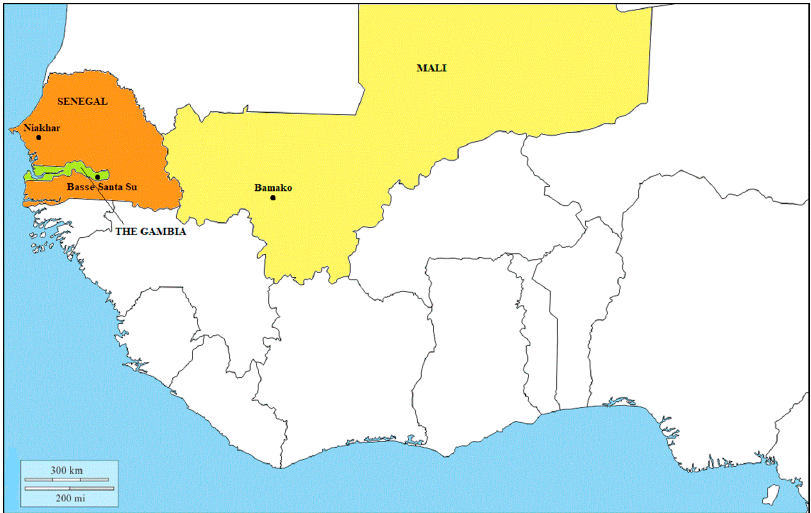
Figure 1. West African region, study sites in Mali (yellow), Senegal (orange) and The Gambia (green).